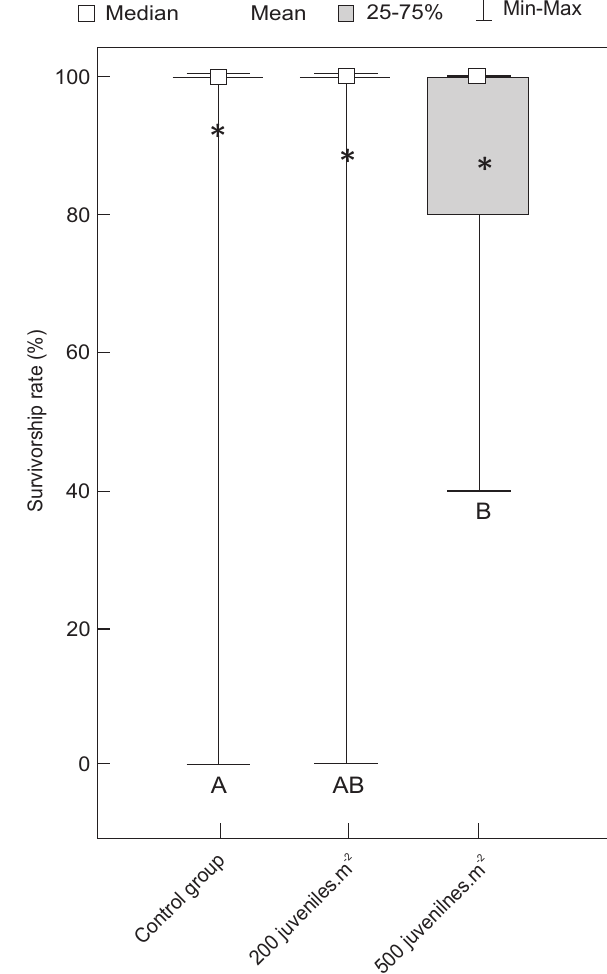
Figure 4. Survivorship rates of U. cordatus juveniles reared at dif- ferent densities. In the control group, juveniles were reared indi- vidually. Letters under boxes indicate homogeneous groups ac- cording to the statistical analysis.